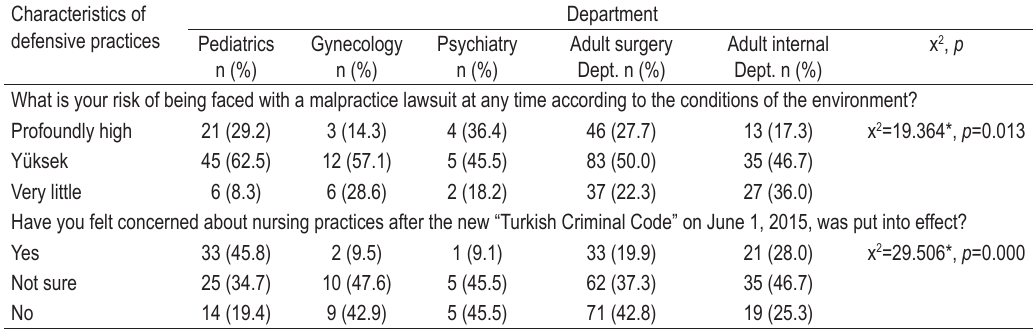
TABLE 4. Nurses’ characteristics of defensive practice in regard to the department (n=345) Characteristics of defensive practices